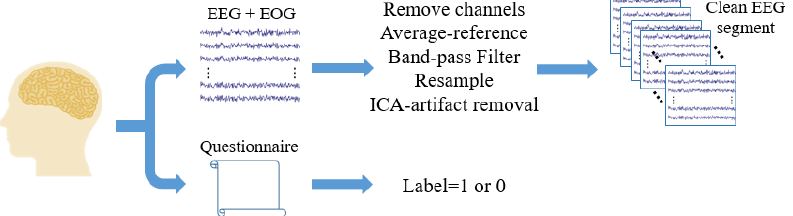
Fig. 1. The process of recording data and data preprocessing in our